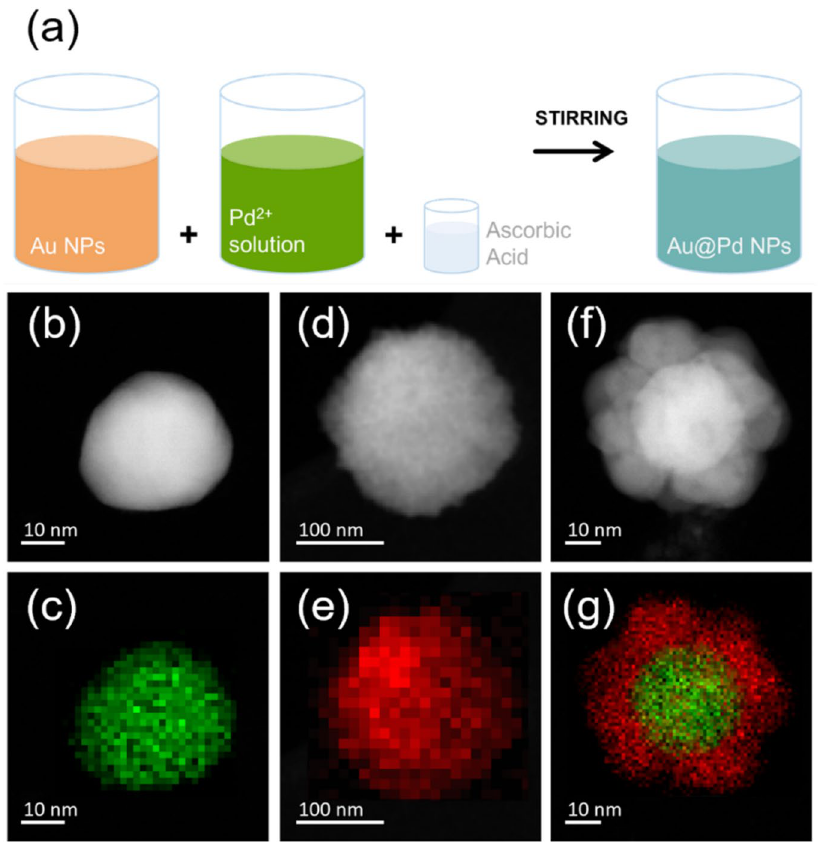
Figure 1. ( a ) Schematic representation of Au@Pd core–shell NPs; STEM ( b , d , f ) images and EDX ( c , e , g ) elemental maps of representative Au ( b , c ), Pd ( d , e ) and Au@Pd ( f , g )